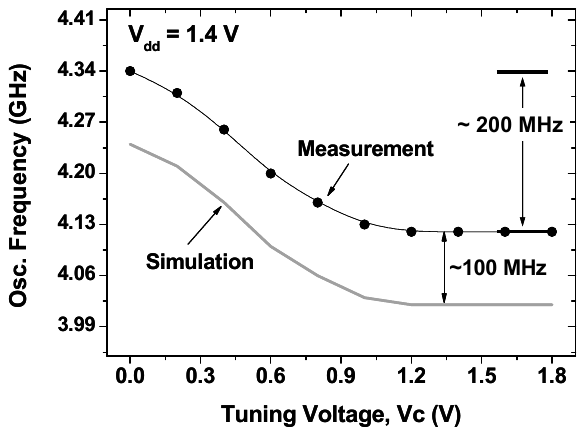
Figure 4. Measured phase noise with offset frequency.